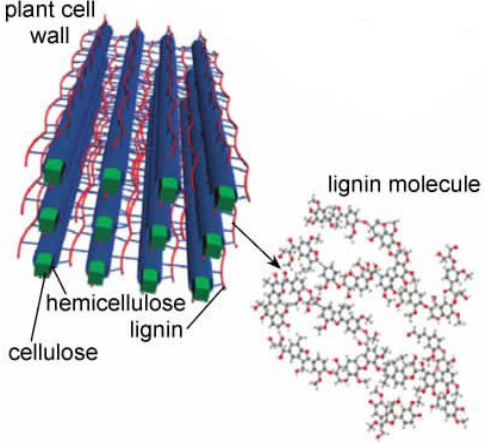
Figure 1. Strctural representation of lignin with cellulose in a plant cell, reproduced with permission from [21].